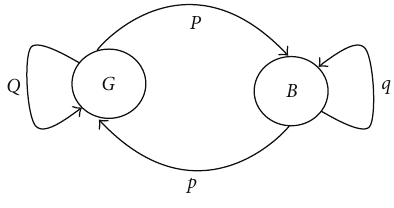
Figure 4: Gilbert-Elliot